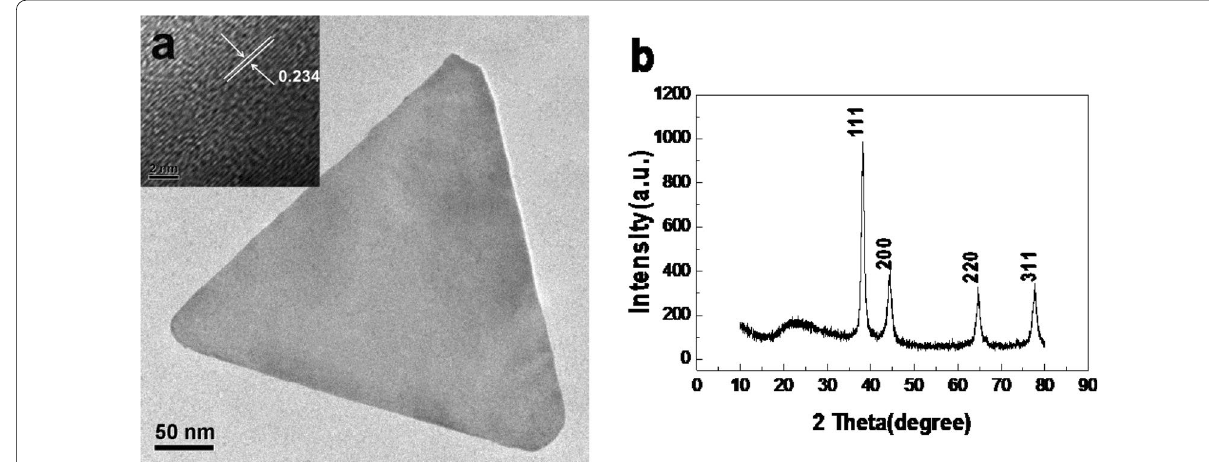
Fig. 6 HRTEM ( a ) and XRD ( b ) characterization of gold nanoplates